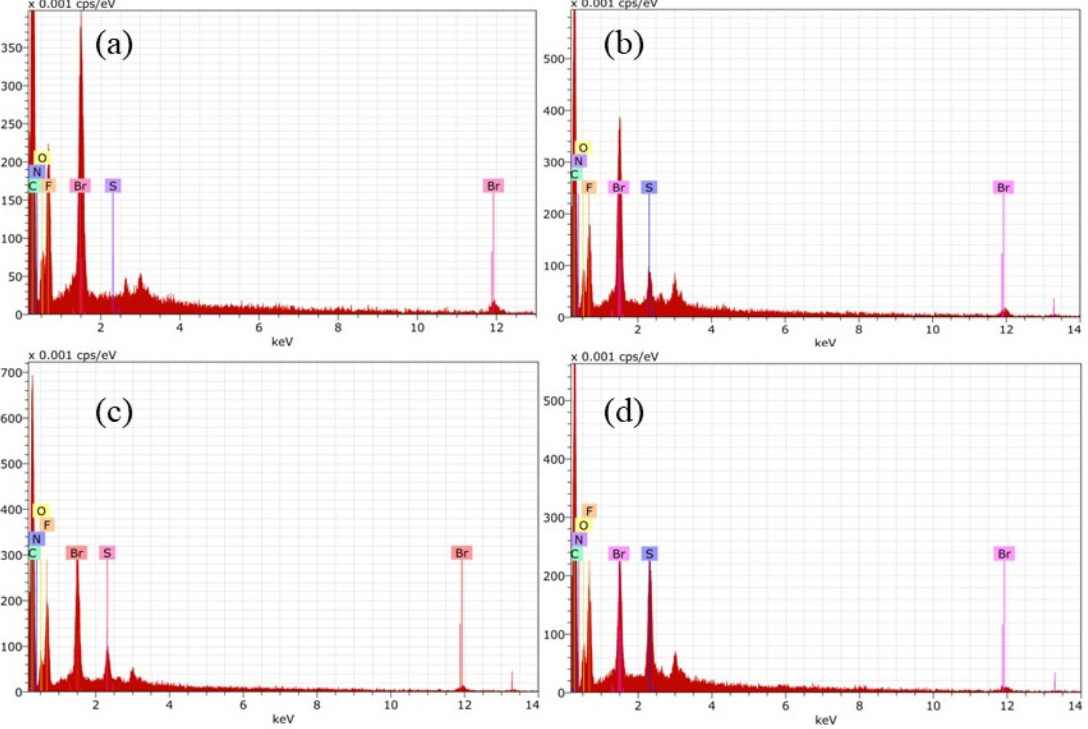
Figure 6. EDS for membranes containing PEI: ( a ) M1, ( b ) M2, ( c ) M3 y ( d ) M4.